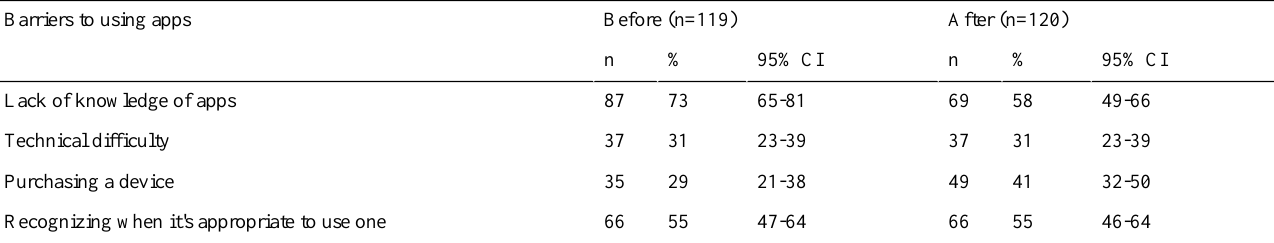
Table 4. Responses regarding student-identified barriers to using apps, before and after the learning experience.